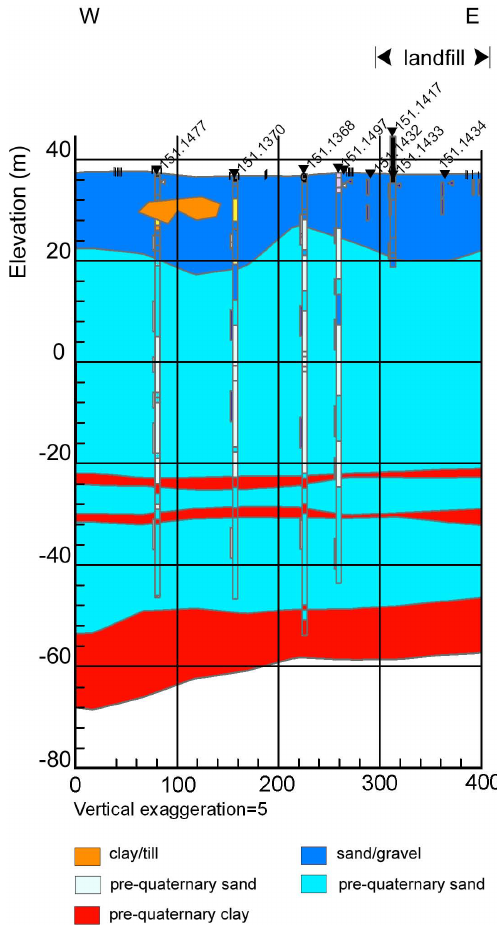
Fig. 3. Simplified geological cross-section (see location in Fig. 1). The glacial sands (shallow dark blue layer) host a regional aquifer. Modified from Pedersen et al.